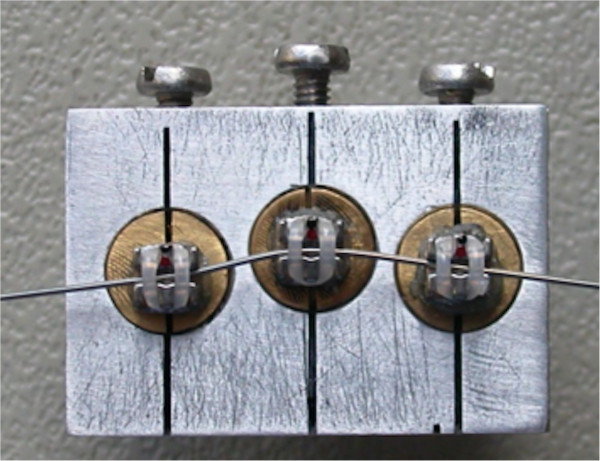
Stainless steel support of the vertical bracket displacement experimental model. The central bracket is 1 mm apically displaced relative to the adjacent brackets.